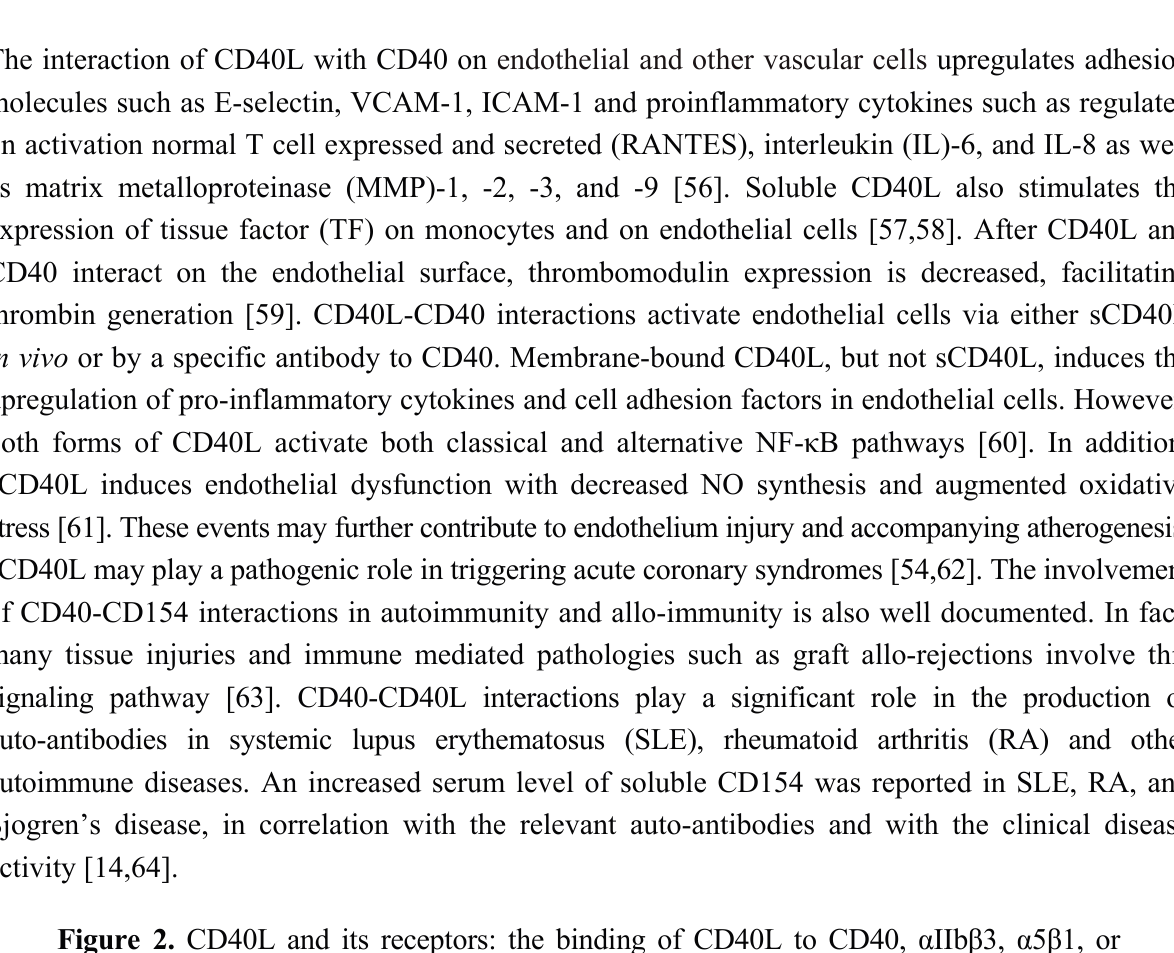
Figure 2. CD40L and its receptors: the binding of CD40L to CD40, α IIb β 3, α 5 β 1, or Mac-1 ( α M β 2) induces different inflammatory pathologies. Systemic lupus erythematosus (SLE), transfusion-related acute lung injury (TRALI), reactive oxygen and nitrogen species (RONS), Myeloperoxidase